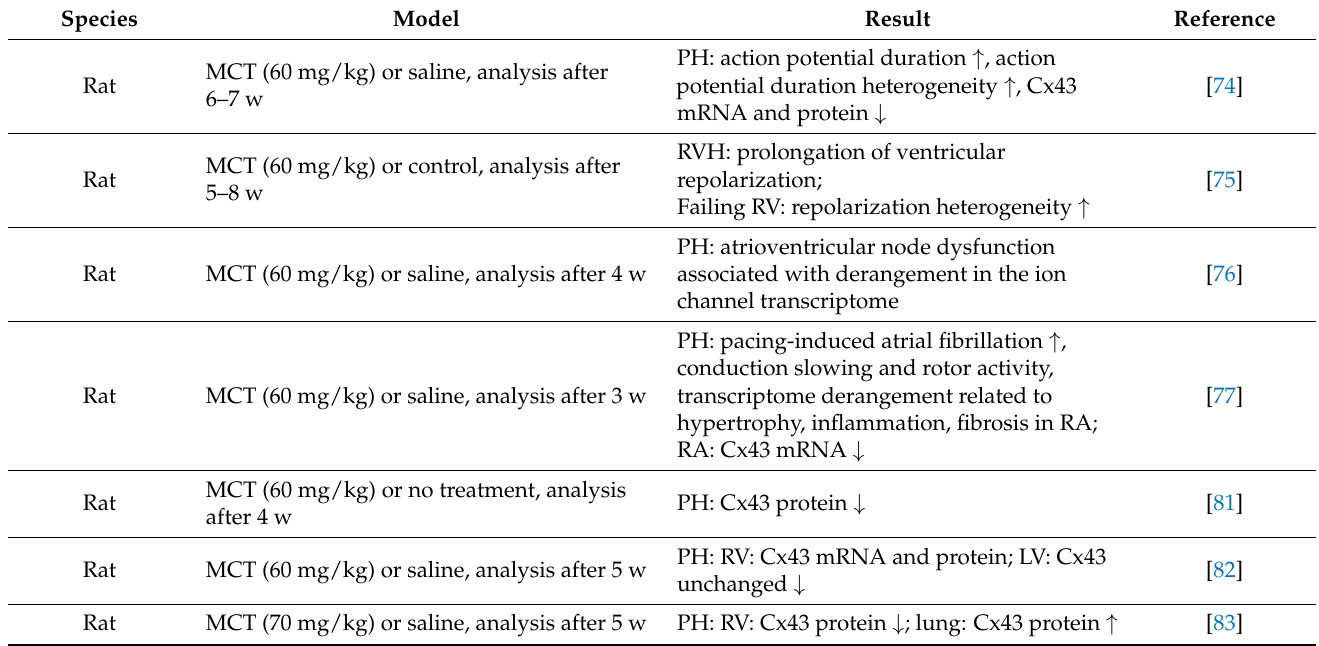
Table 4. Pulmonary hypertension: connexins in RV hypertrophy and